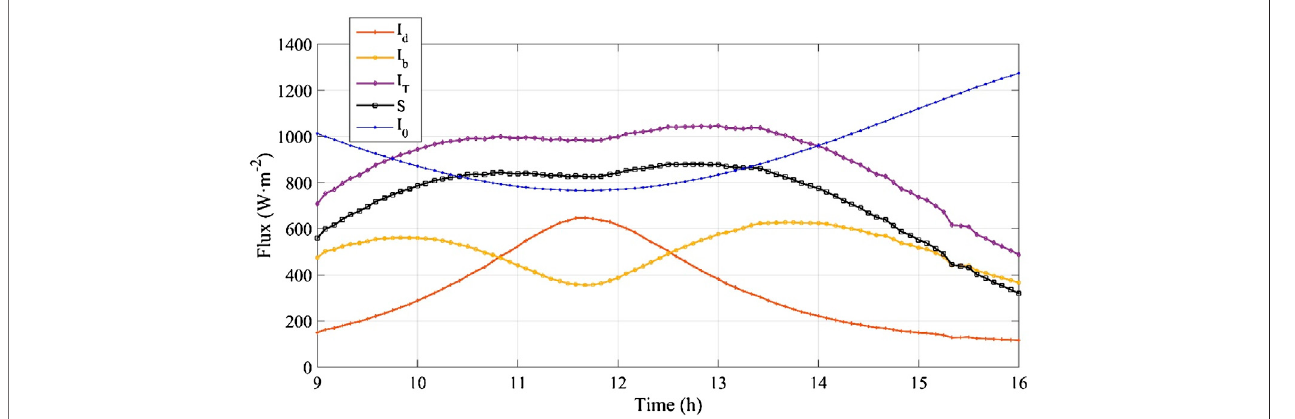
FIGURE 7 | Variation in the fl ux incident on the solar air collectors.